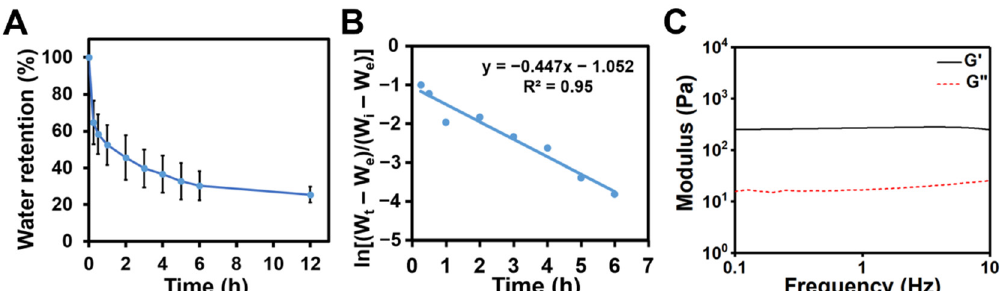
Figure 7. Osmotic-responsive properties of the CC hydrogel at 25 °C. ( A ) Deswelling behavior of the CC hydrogel in the physiological saline. ( B ) The deswelling kinetics shown as ln[( W t − W e )]/( W i − W e )] versus time t . ( C ) The rheological property of the deswollen CC hydrogel after immersion in saline for 12 h.